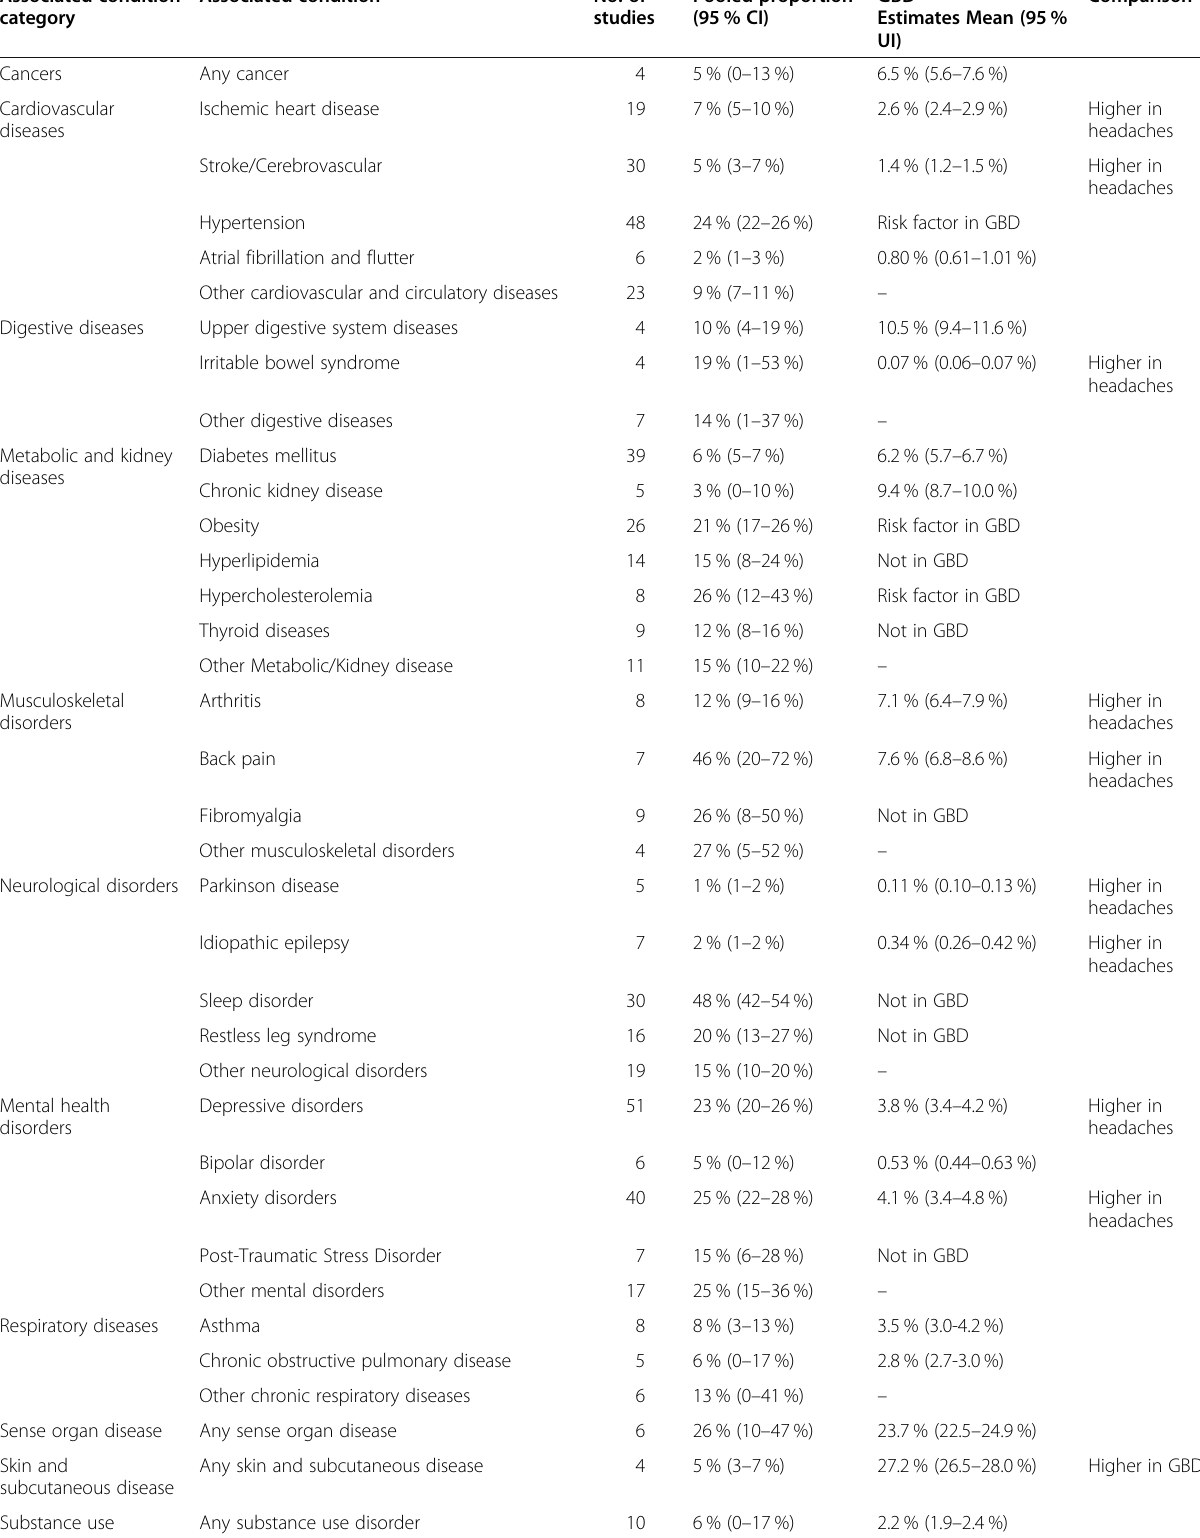
Table 2 Pooled prevalence of selected comorbidities among patients with primary headaches and comparison with 2019 GBD